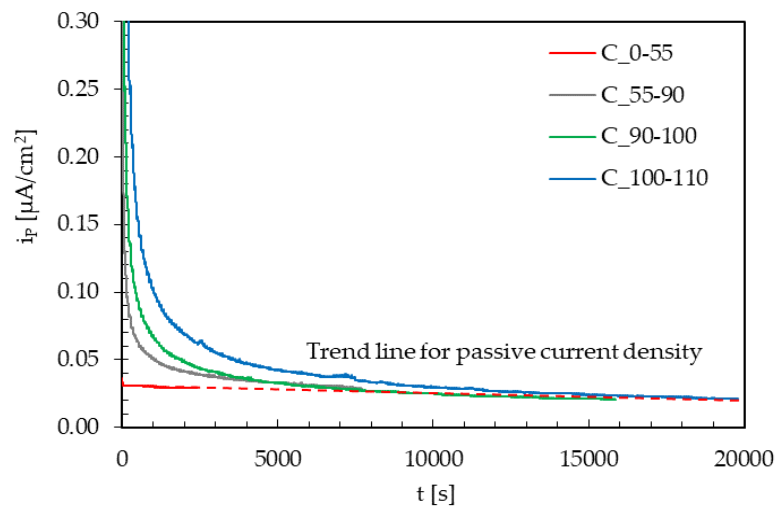
Figure 8. Effect of instant variations of the maximum load (amplitude = ± 10% TYS; frequency = 10 − 2 Hz) on the background passivity current (i P, ∞ ).